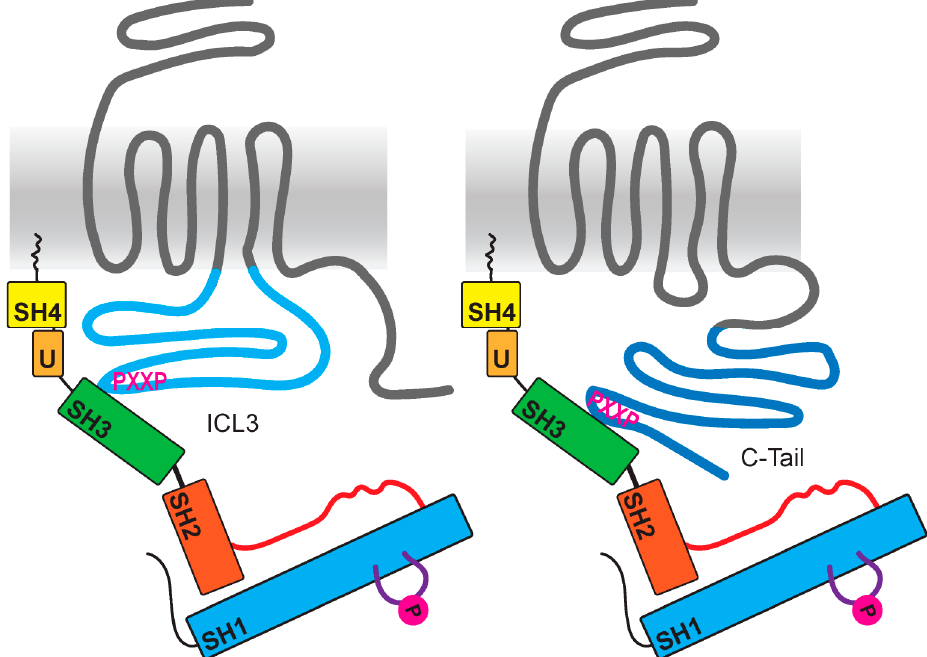
Figure 3. Direct interaction of GPCRs with SFKs through intracellular domains. Some GPCRs (colored in grey) encode polyproline motifs (shown in magenta) either in their third intracellular loop (light blue) or in their C-tail (colored in dark blue). For several receptors, an SFK SH3 domain (shown in green) interaction was verified.